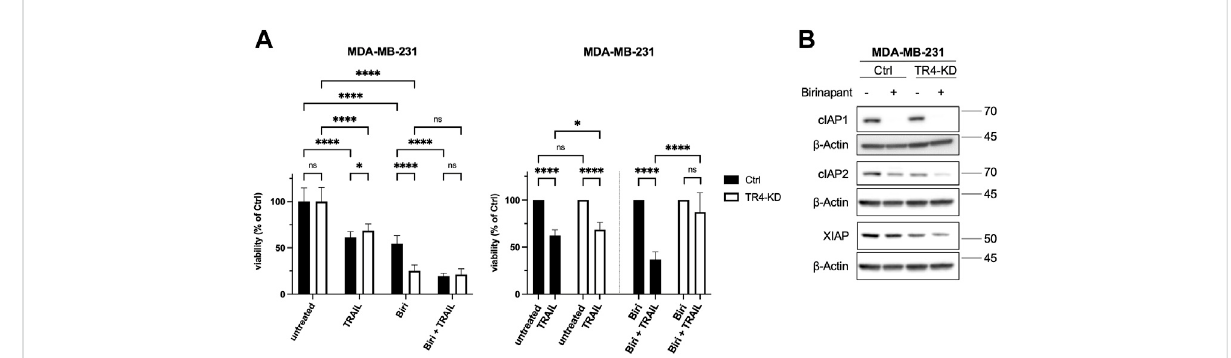
FIGURE 9 InhibitionofIAPsdrasticallyreducestheviabilityofMDA-MB-231TRAIL-R4-KDcells. (A) MDA-MB-231control(Ctrl)andTRAIL-R4-knockdown (TR4-KD) cells were treated with either TRAIL (100 ng/ml) or Birinapant (1 μ M; Biri), or combination of both. Viability of cells was studied 24 h after TRAIL addition by crystal violet viability assay. Shown are the mean ± SD of 3 biological replicates ( n = 3). All experiments were performed in 12 technical replicates. The asterisks (*/**/****) indicate signi fi cance ( p < 0.05/ < 0.01/ < 0.0001). (B) Western blot showing effects of Birinapant treatment (1 μ M, 6 h) on the levels of cIAP1, cIAP2 and XIAP in MDA-MB-231 cells with and without TRAIL-R4-KD. Detection of β -Actin served as a loading control. Shown are representative pictures from one related experiment out of four biological